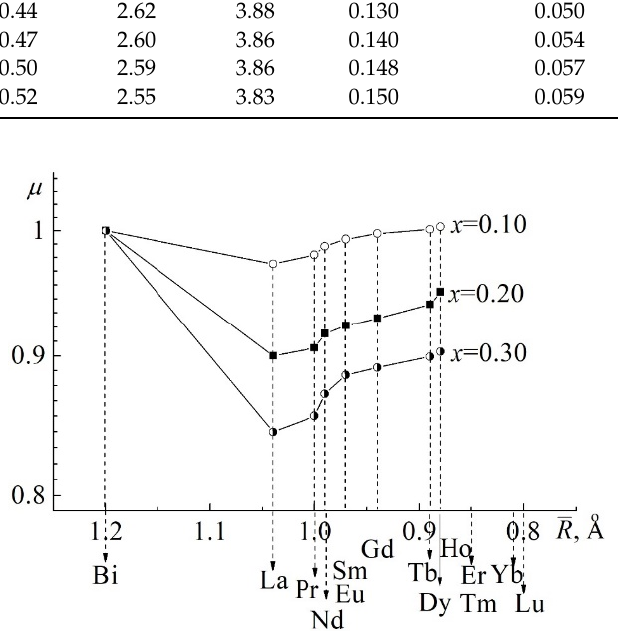
Figure 9. Dependences of μ REE on radii, R , in BiFeO 3 SS with x = 0.1; 0.2; 0.3.